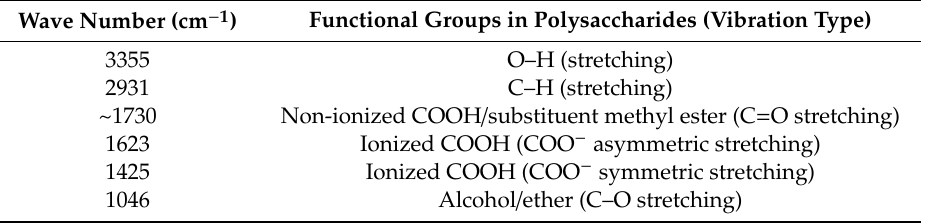
Table 4. Main functional groups in the FTIR spectra of cactus cladodes